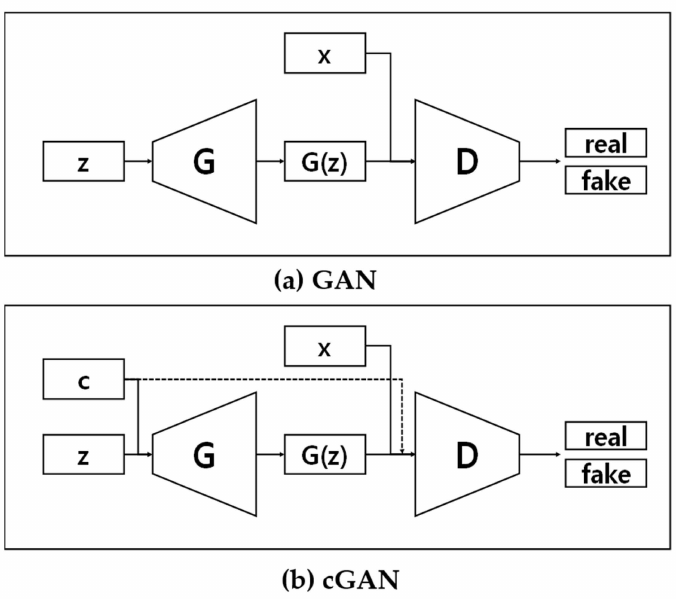
Figure 1. Architectures of ( a ) the generative adversarial network (GAN) and ( b ) conditional genera- tive adversarial network